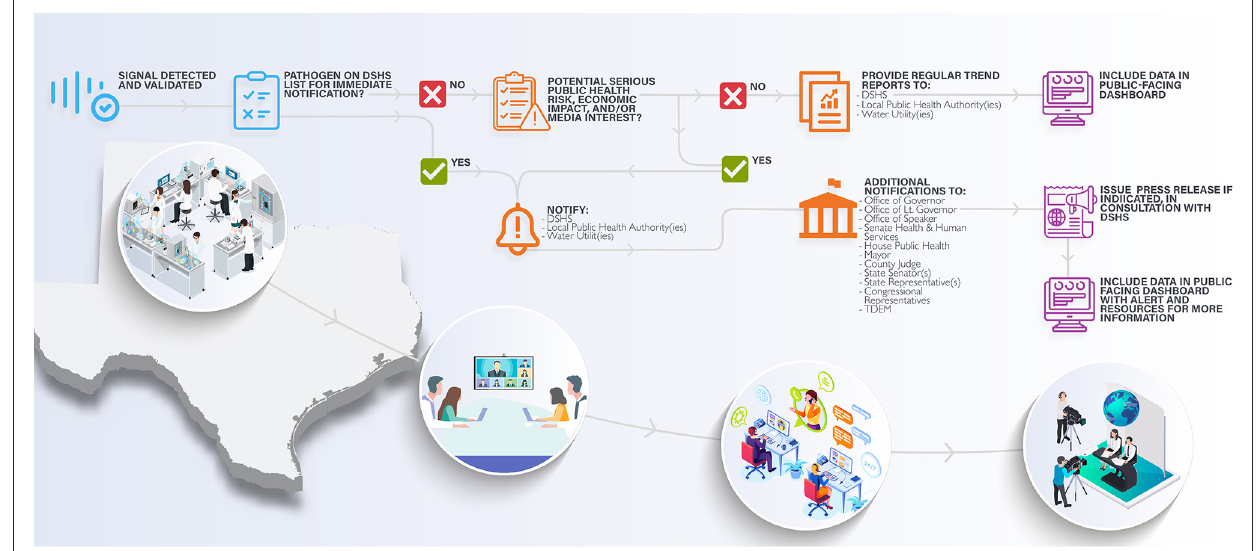
FIGURE2 The wastewater detection notification scheme and network. Validated viral detection events of concern are assessed first for whether they are on the DSHS immediate notification list. DSHS as well as other stakeholders (local public health experts, state leaders, and/or utilities) are notified with additional action dependent on the threat of the concern (for example, smallpox vs. influenzae). Additional actions such as consultation with stakeholders and/or a press release may be needed. Viruses of seasonal or endemic nature (influenzae, SARS-CoV-2, RSV) are automatically entered into a real-time trend analysis with user-friendly reports provided on a regular basis (dependent on whether the targeted or agnostic method is being used). Long-term goals include a user-friendly community data set segmented in time, space, and viral species or variant